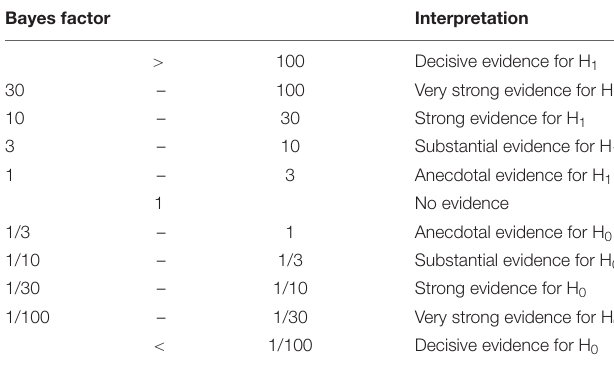
TABLE 3 | Interpretation of the Bayes factor (Jeffreys,